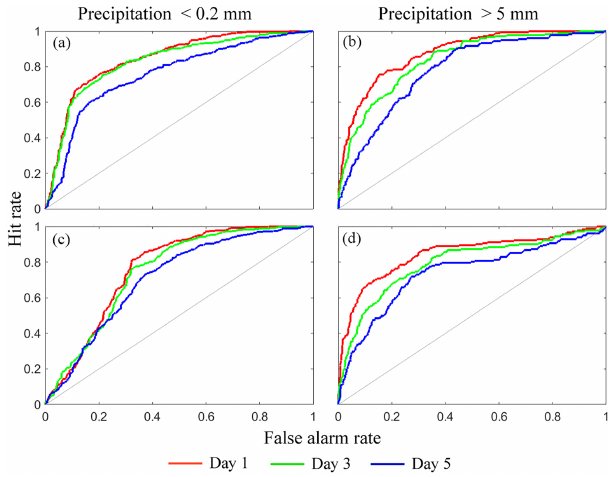
Figure 4. Relative operating characteristic (ROC) curves at lead times of 1, 3, and 5 days for calibrated QPFs for events of pre- cipitation less than 0.2mm and events of precipitation greater than 5mm for subcatchment 11. Panels (a) and (b) show ROC curves of calibrated GEFS, and panels (c) and (d) show ROC curves of cali- brated GDPS. In the calculation of ROC, the daily data from 2013 to 2015 are